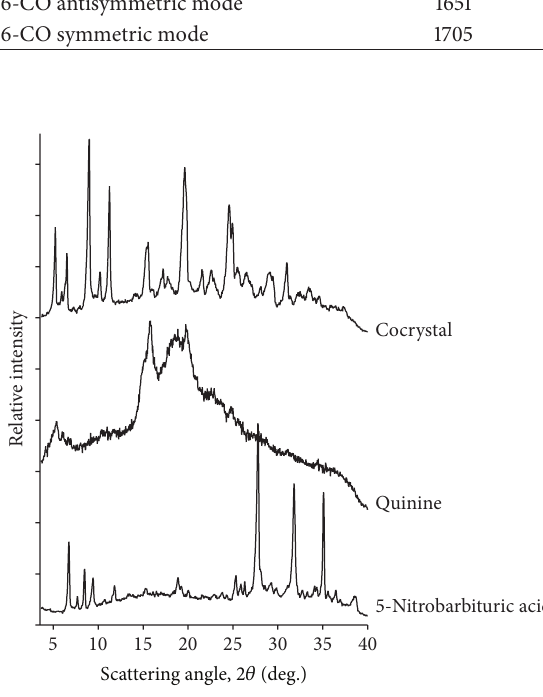
Figure 8: Raman spectra within the fingerprint region of 5- nitrobarbituric acid, cinchonidine, and the 1: 1 nitrobarbituric- cinchonidine cocrystal.